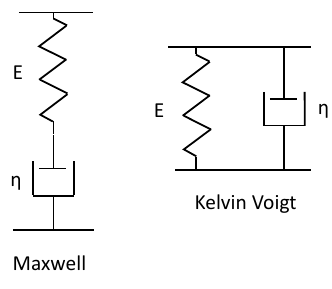
Figure 1. Rheological models.